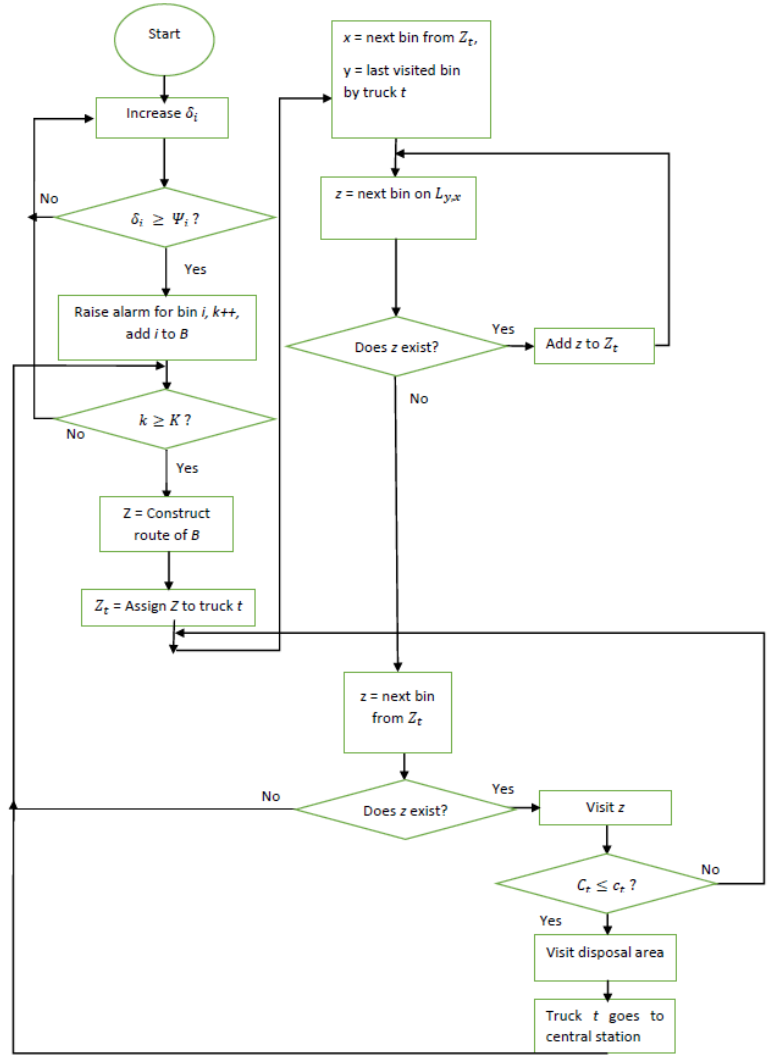
Figure 3. Collect based on Upper Threshold (CUT)